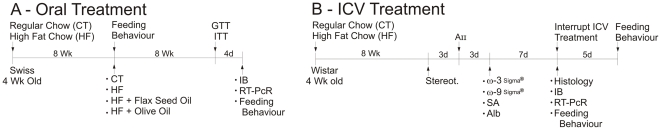
Experimental protocols.A, Four-week old male Swiss mice were fed regular chow (CT) or high-fat diet (HF) for eight weeks and then randomly divided into eight groups: CT mice, maintained for another eight weeks on the same CT diet; or HF mice which were either maintained on the same HF diet; or transferred to diets containing substitution of lard by olive or flax seed oils to final concentrations of 10, 20 or 30%, according to Table 1. At the end of the experimental period, the mice were submitted to a glucose tolerance test (GTT) and an insulin tolerance test (ITT), four days later, feeding behavior was evaluated and samples were obtained for immunobloting (IB) and real-time PCR (RT-PCR). B, Four-week old male Wistar rats were fed for eight weeks on CT or HF diets and then submitted to intracerebroventricular (icv) cannulation. Drinking response elicited by angiotensin II (AII) was tested three days after cannulation and responsive rats were treated icv with either ω3, ω9, stearic acid (SA) or diluents (Alb) for seven days. Feeding behavior and body mass were determined throughout the experimental period. At the end of the experimental period some rats were randomly selected for histology, IB and RT-PCR; the remainder of the rats was followed up for feeding behavior for an additional five days after the discontinuation of icv treatment.